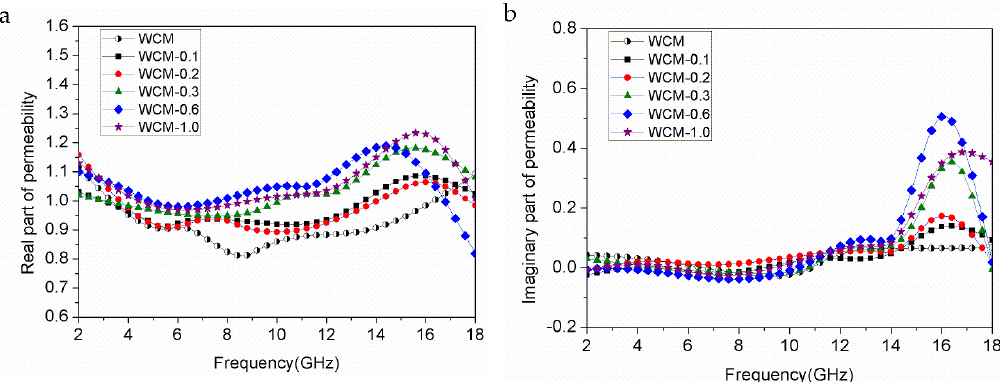
Figure 5. Complex permeability of α-Fe/Fe 3 C/woodceramic nanocomposites as a function of frequency ( a ) real part of permeability; ( b ) imaginary part of permeability.